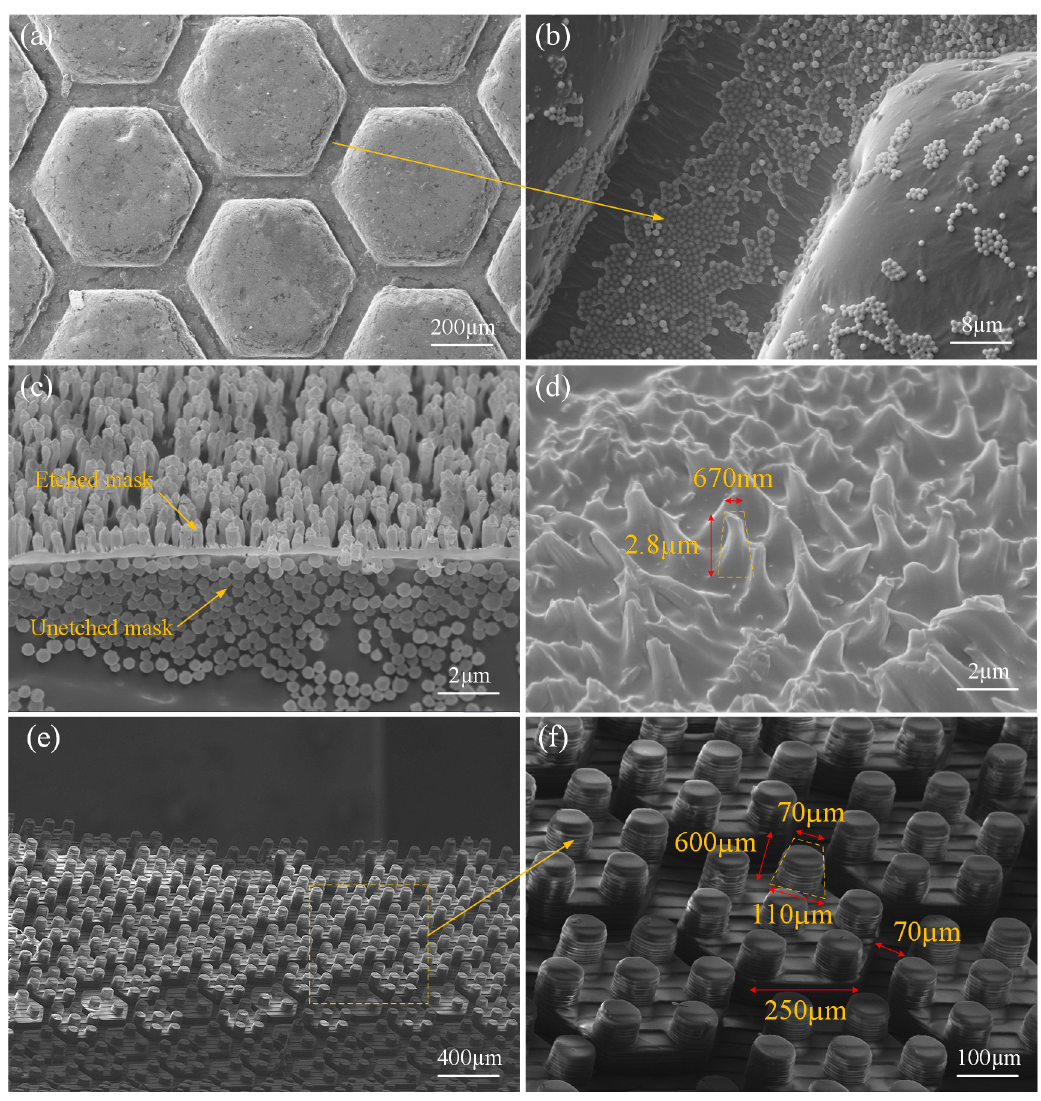
Figure 9. Morphology of the hierarchical structures: ( a ) a hexagonal microstructure substrate covered with a PMMA mask, the yellow arrow represents the boundary of the hexagonal microstructure; ( b ) the distribution of PMMA mask microspheres on the boundary of the hexagonal microstructure and in the groove; ( c ) surface etched by oxygen and sulfur hexafluoride plasma; ( d ) small-scale hierarchical microstructure after removing residual PMMA mask microspheres; ( e , f ) large-scale hierarchical microstructure manufactured by 3D printing demolding, the yellow arrow represents the details of the large-scale hierarchical microstructure.